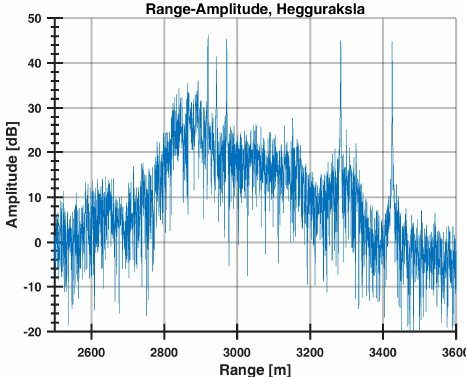
Figure 7. A section of the range–amplitude plot showing the distinct reflections from the six triangular corner reflectors. Note that the first peak contains both reflectors 1 and 3, as they are separated by just three range-cells. The range plot is range-compensated for by a range factor of R 4 according to the radar equation [8]. The corner reflectors are in a range from 2900 to 3400 m. The radar cross section of the reflectors is 36.2 dBsm at 9.65 GHz.